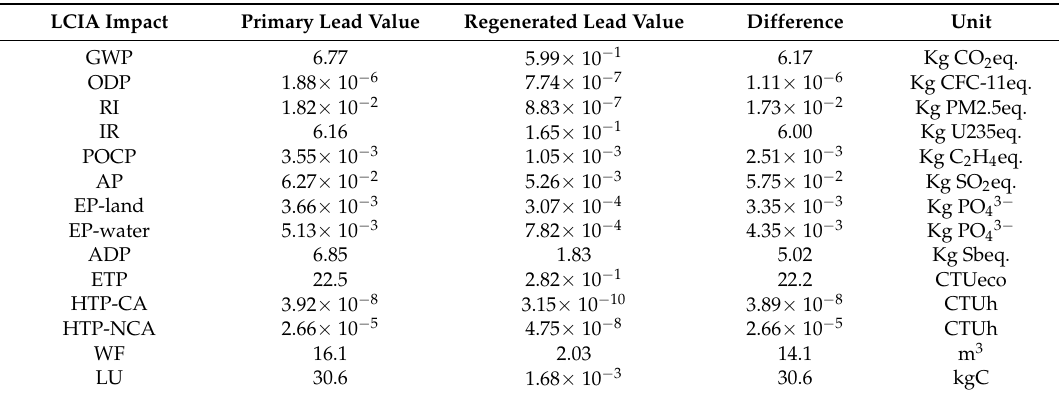
Table 5. The environmental burdens of primary and regenerated lead of 1 KVAh capacity in LABs.